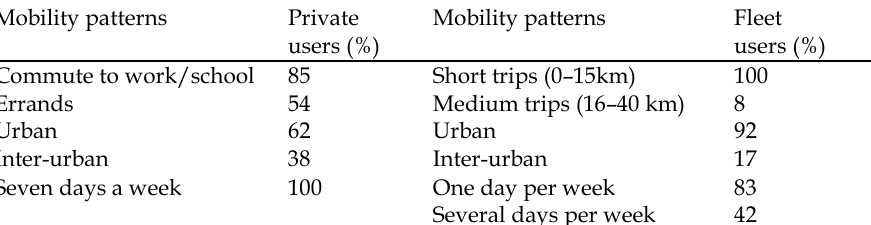
Table 8 Private and fleet users’ mobility patterns (percentage of participants)